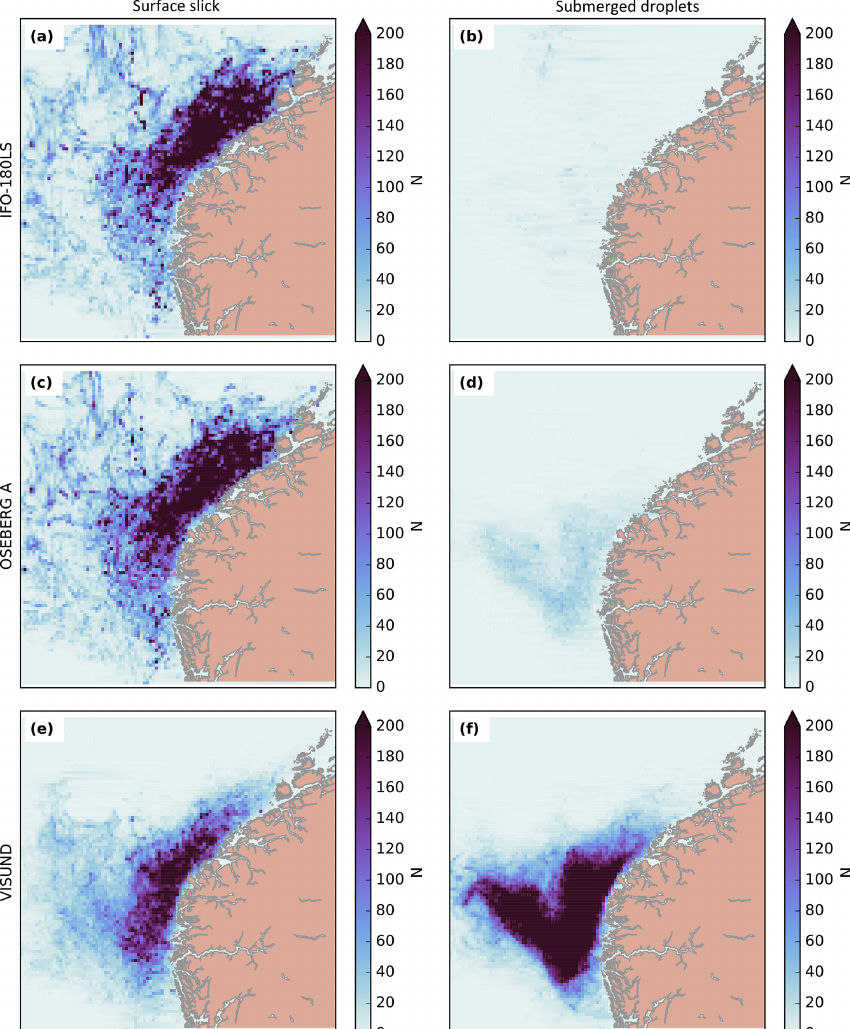
Figure 8. Horizontal concentration maps (number of particles per 100km 2 ) for stochastic oil spill simulations after 10 days summed over 72 simulations for each oil type. Submerged oil (b, d, f) and surface oil (a, c, e) are displayed